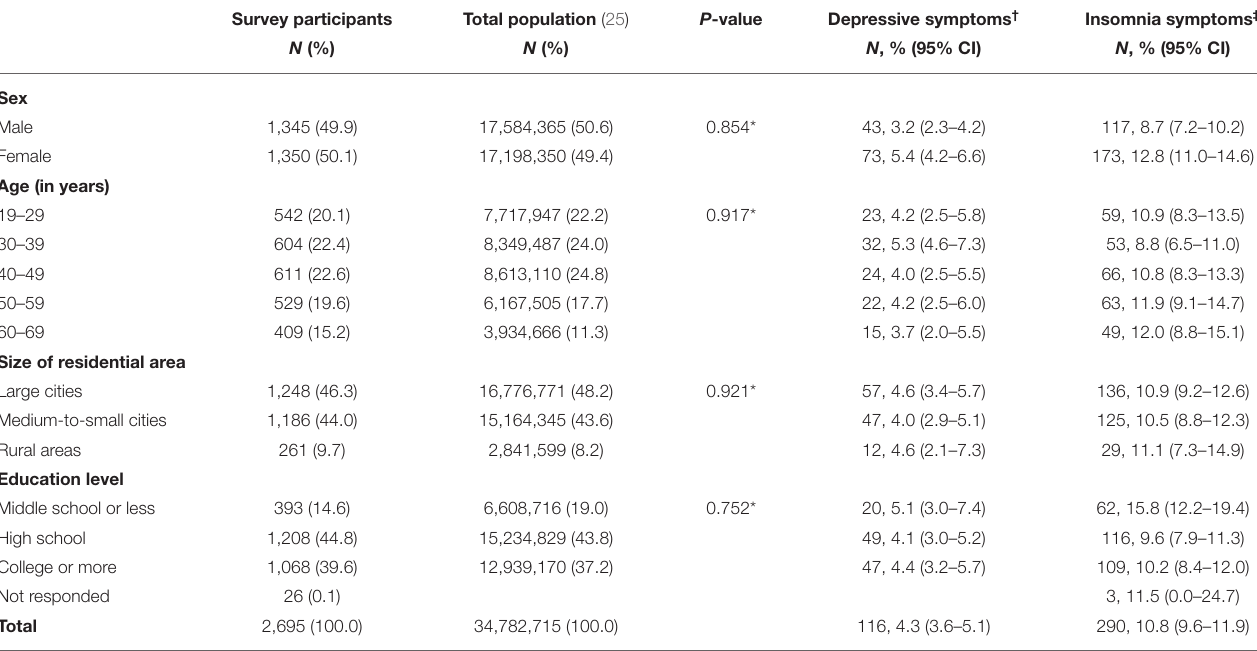
TABLE 1 | Sociodemographic characteristics of the survey participants, total population in the Republic of Korea, and survey cases identified as having depressive symptoms and insomnia